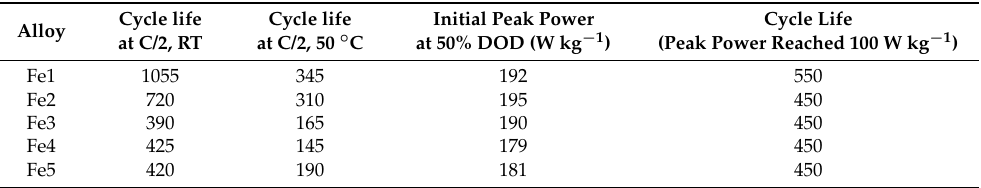
Figure 4. Cycle life performances of cells Fe1 to Fe5 measured at ( a ) RT and ( b ) 50 °C at a charge/discharge rate of C/2. Table 3. Cycle life and peak power performances for cells Fe1 to Fe5. The cycle life tests were performed at RT and 50 °C, at a charge/discharge rate of C/2. Peak power was measured at 50% depth-of-discharge (DOD).